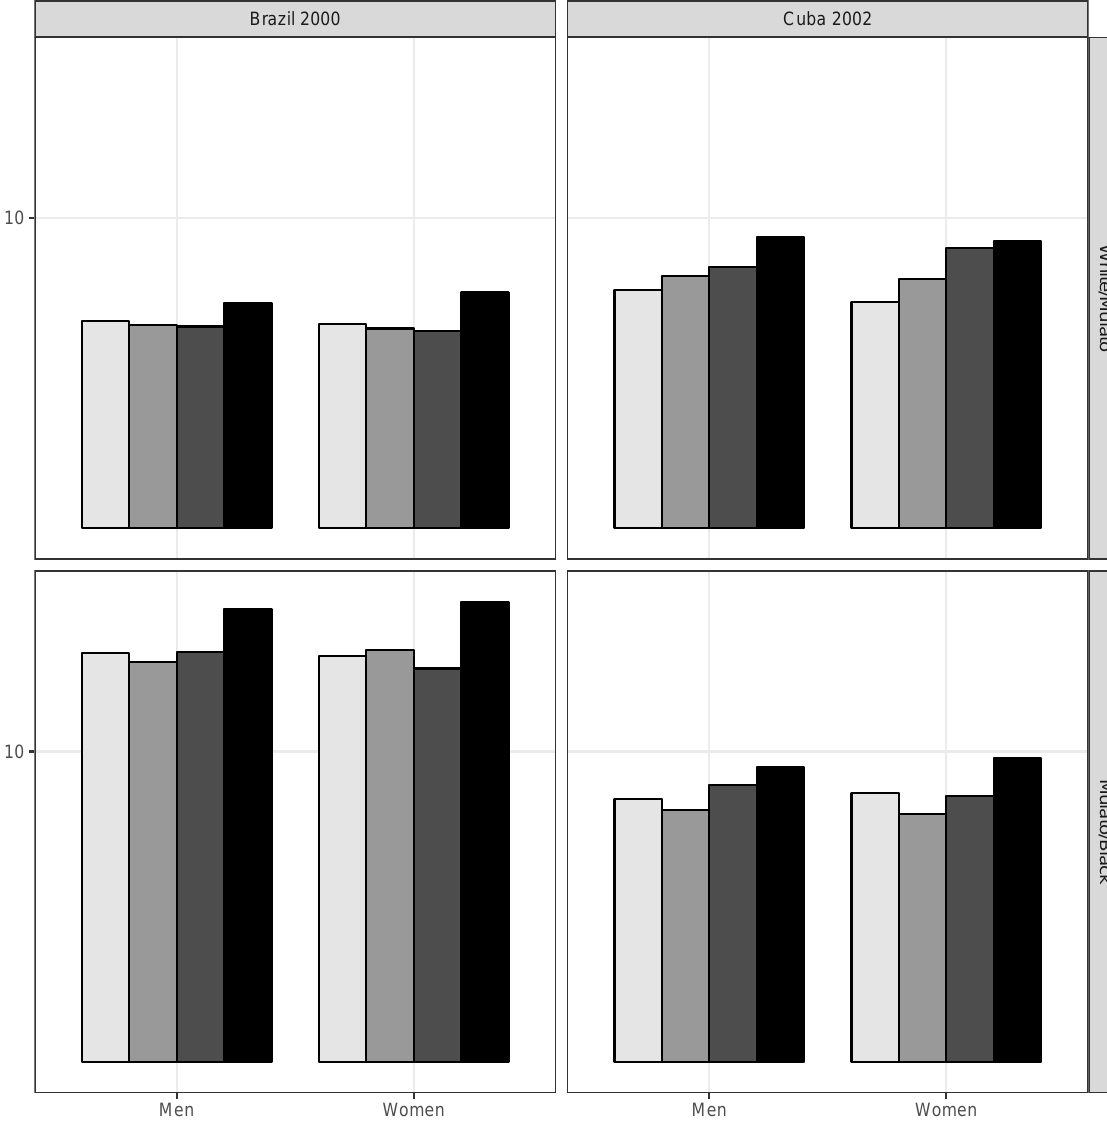
Figure 3: Estimated odds ratios for endogamy levels between mulato –black and white– mulato racial pairings by educational attainment among married and cohabiting unions of women aged 25 to 34 in Brazil 2000, Cuba 2002, and the United States 2000 (model 5). Source : Own calculations based on census microdata,